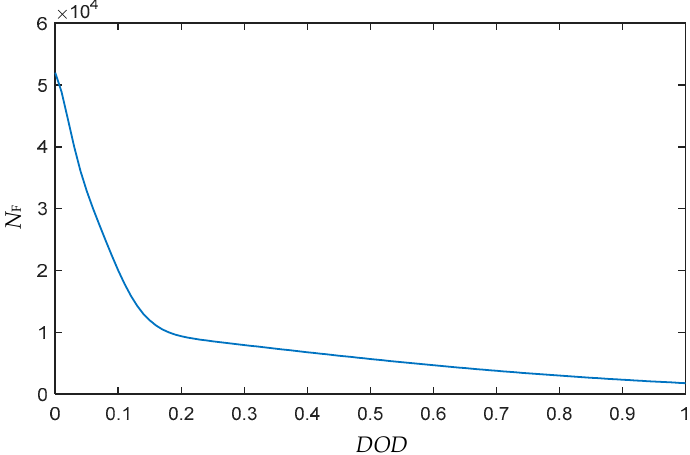
Figure 1. Typical correlation profile of the maximum cycles and depth of the discharging ( DOD).